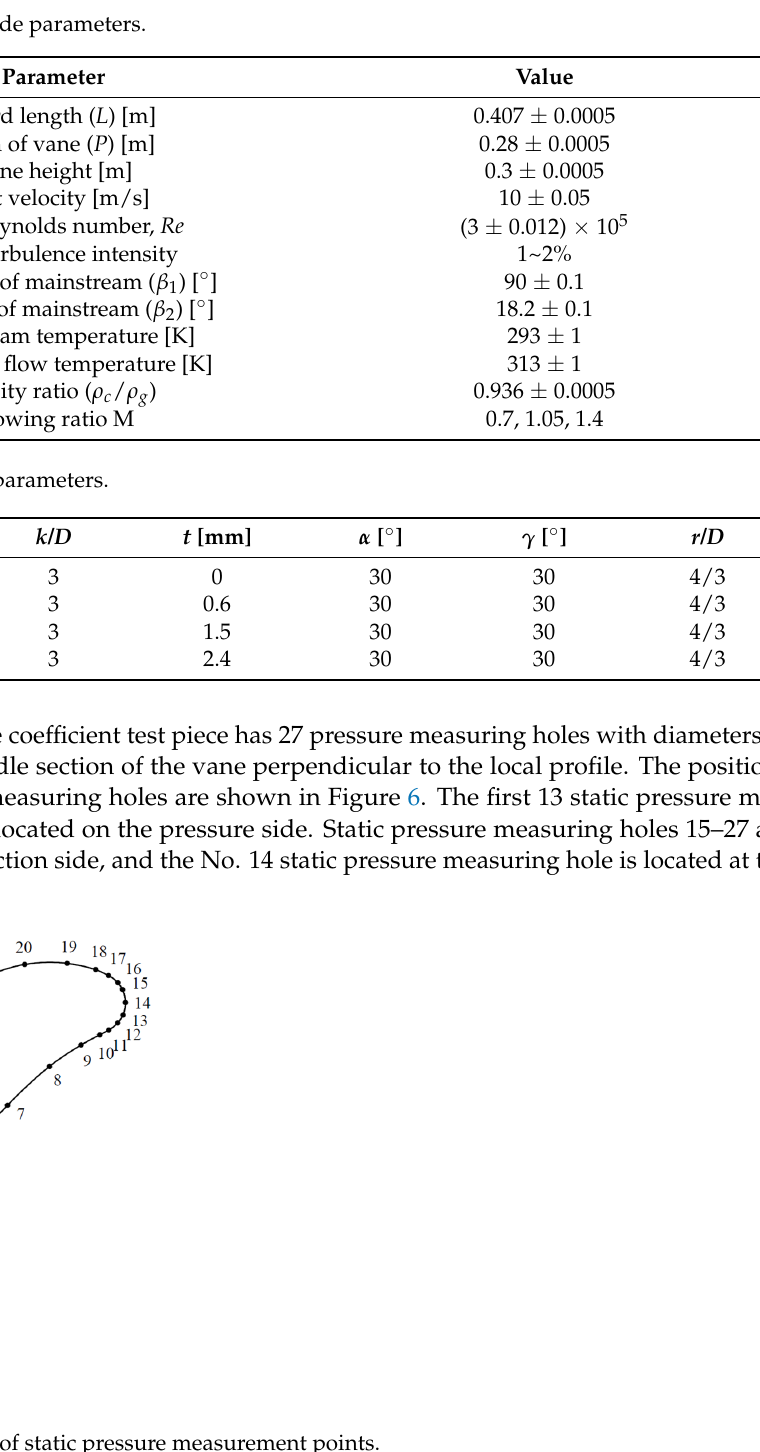
Figure 6. Positions of static pressure measurement points.